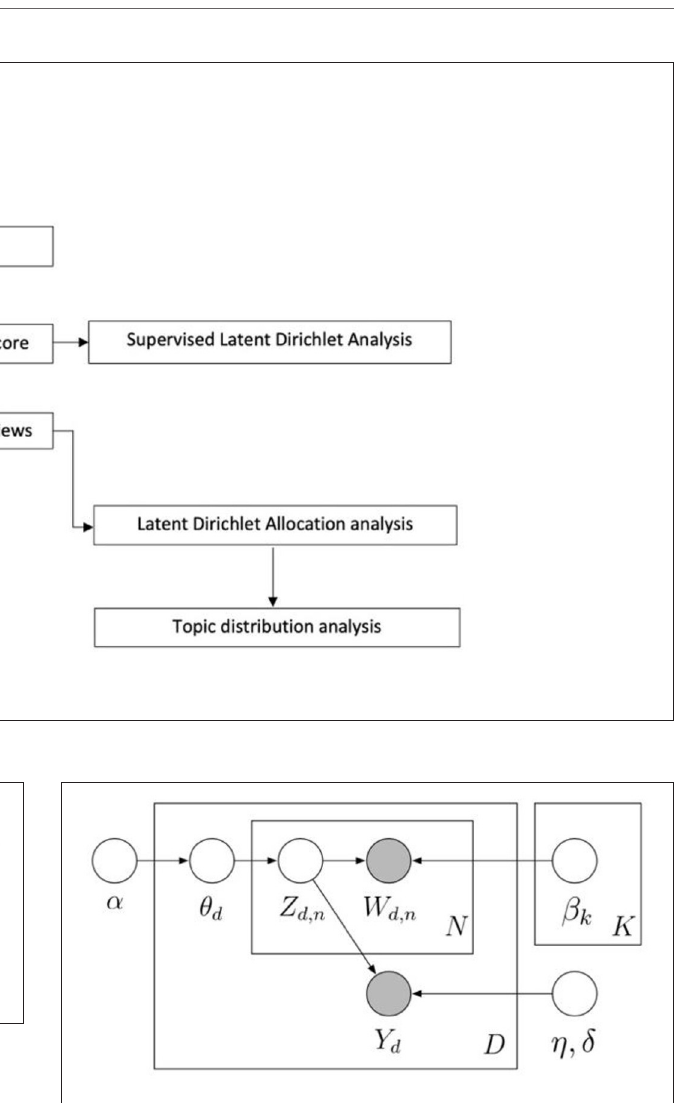
FIGURE 3 | Graphical model representation of sLDA (Blei and McAuliffe, 2007